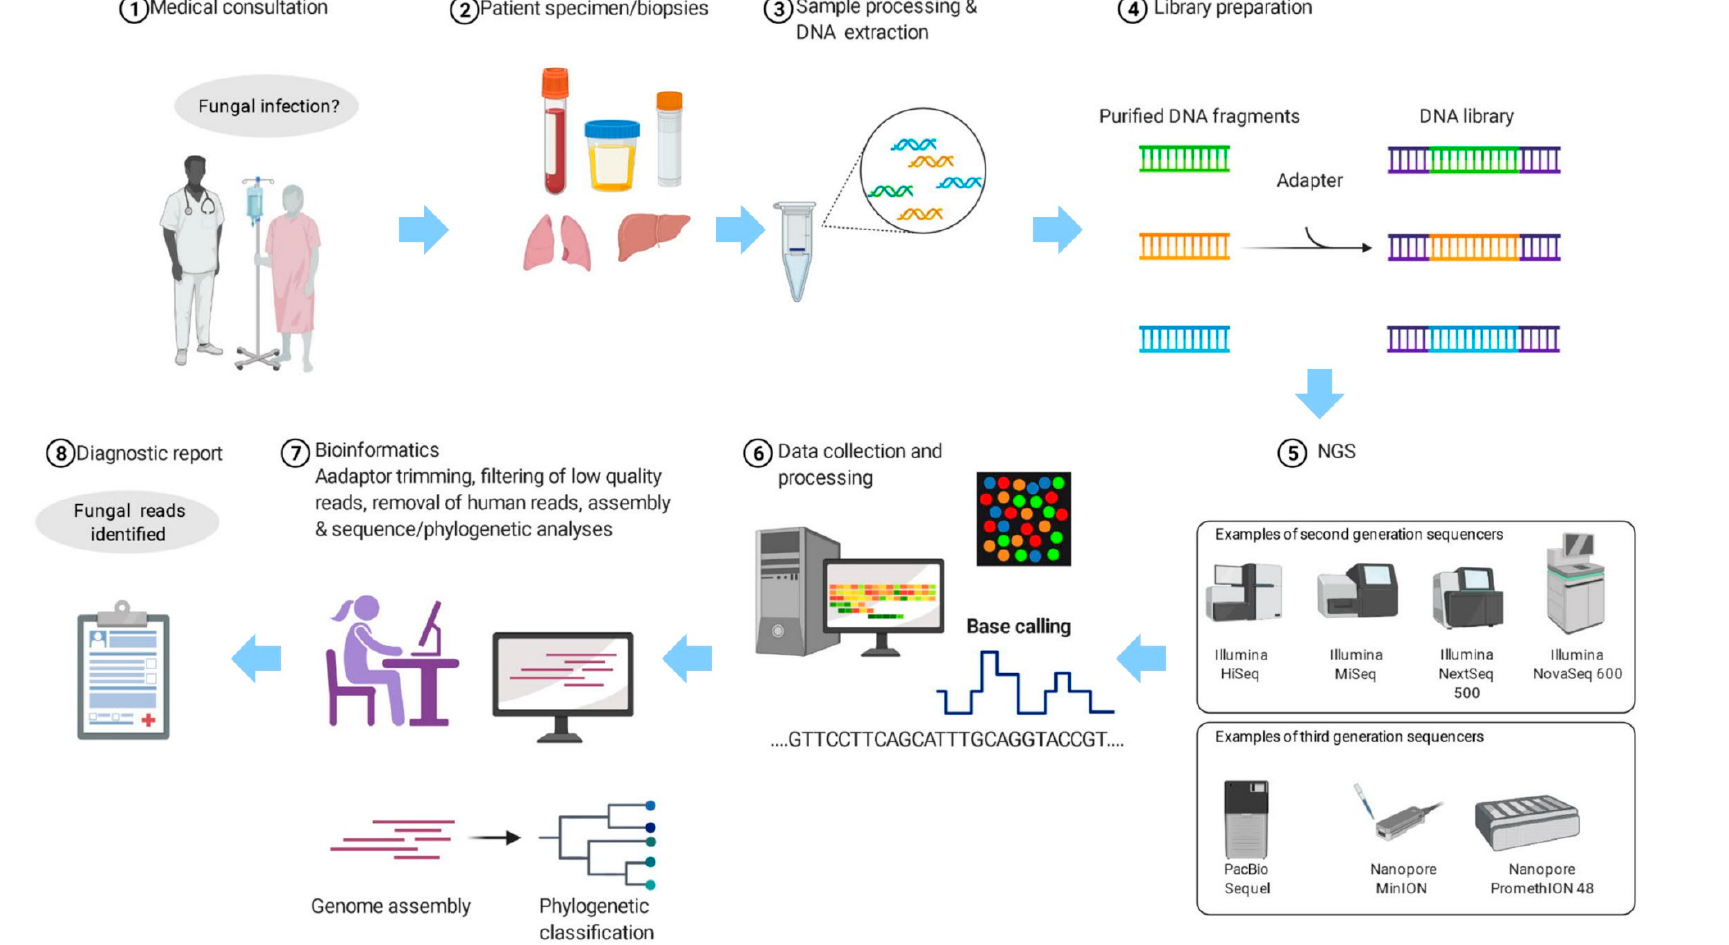
Figure 1. The workflow of using next-generation sequencing (NGS) for the diagnosis of suspected fungal infection.